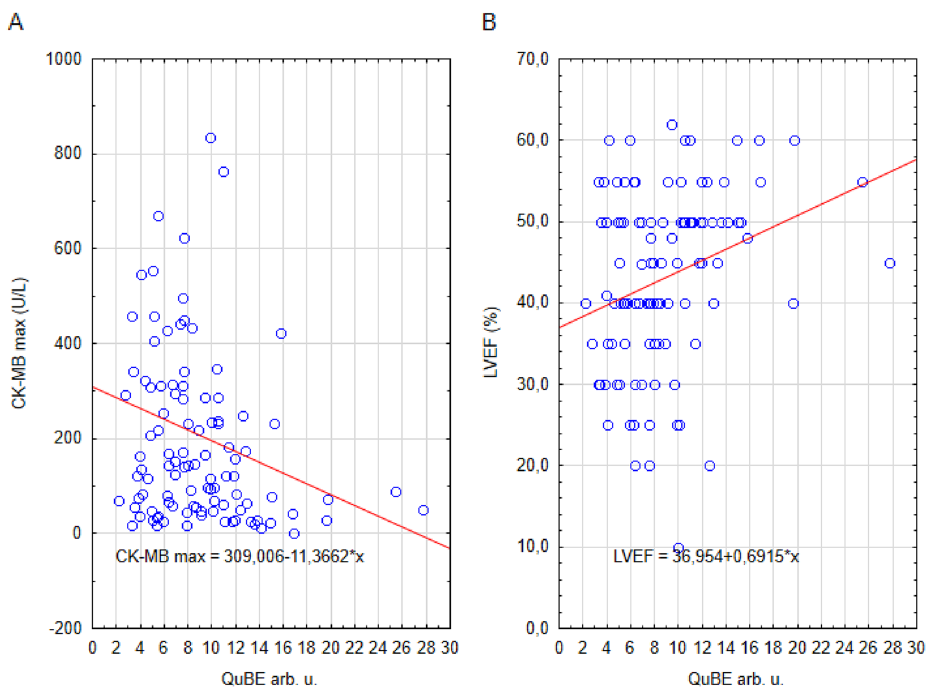
Figure 1. Graphical presentation of the relationship between peak CK-MB activity and QuBE ( A ) as well as LVEF and QuBE ( B ) in T2DM